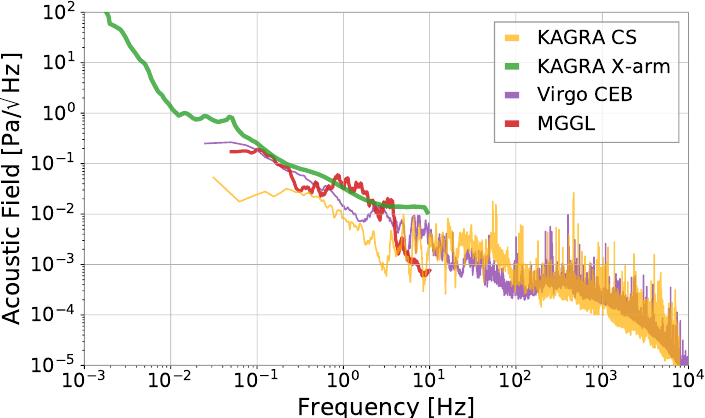
Figure 13. Comparison of the acoustic fields for the gravitational experimental sites: KAGRA CS [48], KAGRA X-arm [42], Virgo CEB [48], and MGGL [49].